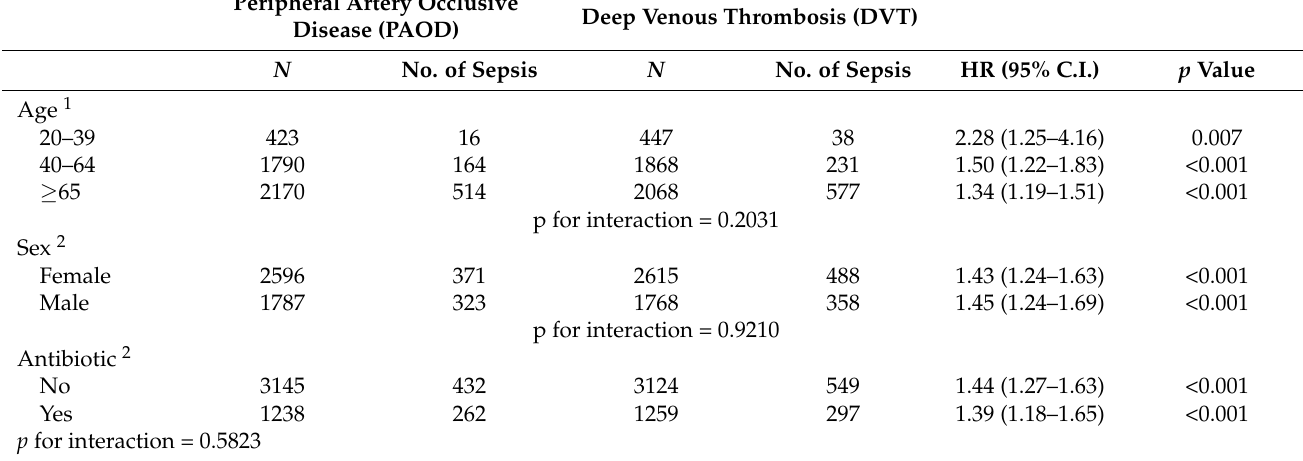
Table 4. Subgroup analysis of risk of